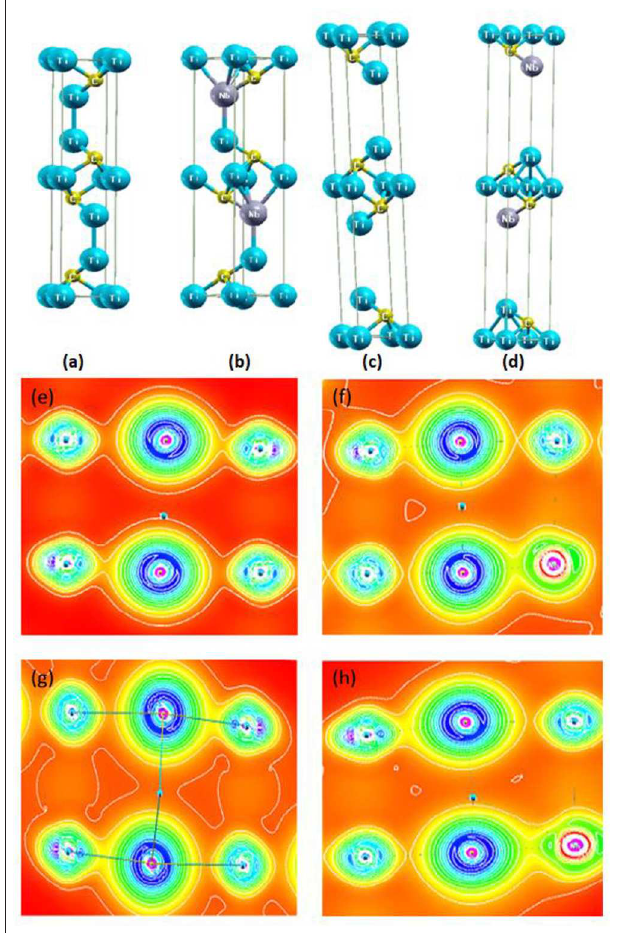
FIGURE 2 | Structures of (a) Ti 3 C 2 , and (b) NbTi 2 C 2 based on the relaxed parameter and structure of (c) Ti 3 C 2 , and (d) NbTi 2 C 2 based on the experimental lattice parameter. Electron density of the relaxed structures for (e) Ti 3 C 2 , and (f) NbTi 2 C 2 . Electron density of the experimental structures for (g) Ti 3 C 2 , and (h) NbTi 2 C 2